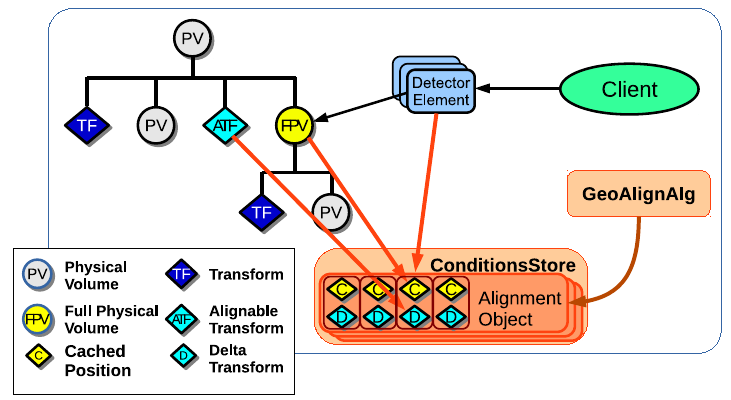
Figure 3. Concurrent implementation of the ATLAS Geometry Model and Detector